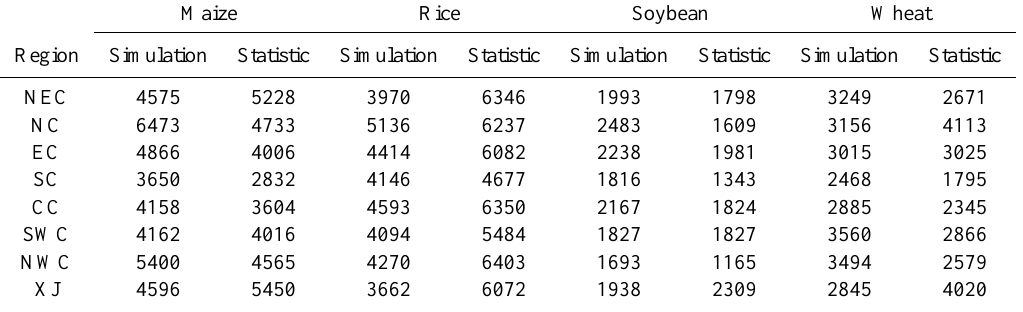
Table 2. Simulated and statistical yields in the eight regions of China in 1981–2010 (kgkm − 2 ). Maize